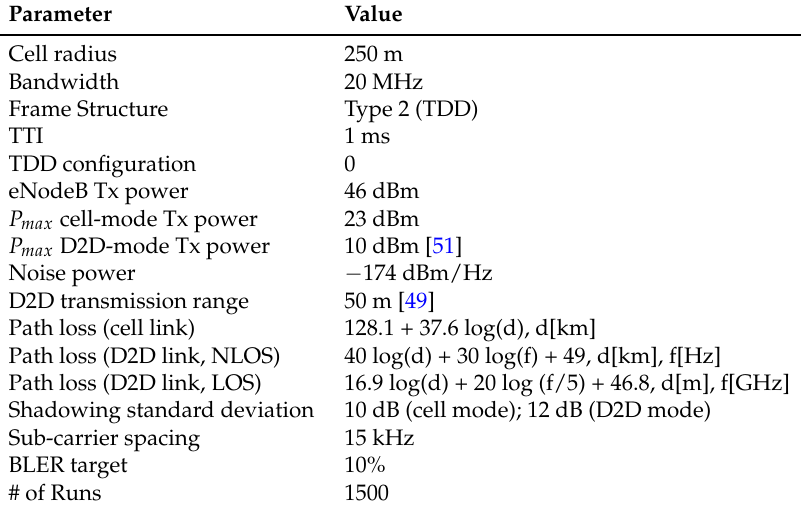
Table 3. Main Simulation